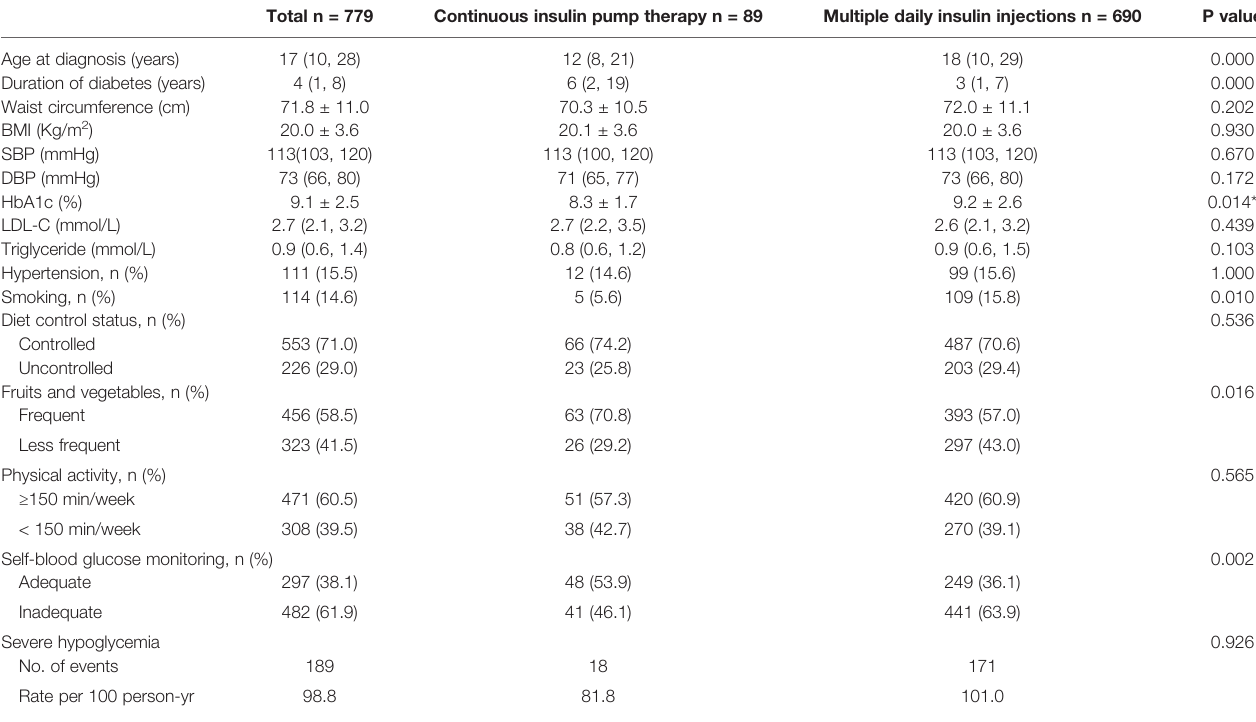
TABLE 2 | Clinical and lifestyle characteristics of people with type 1 diabetes by insulin